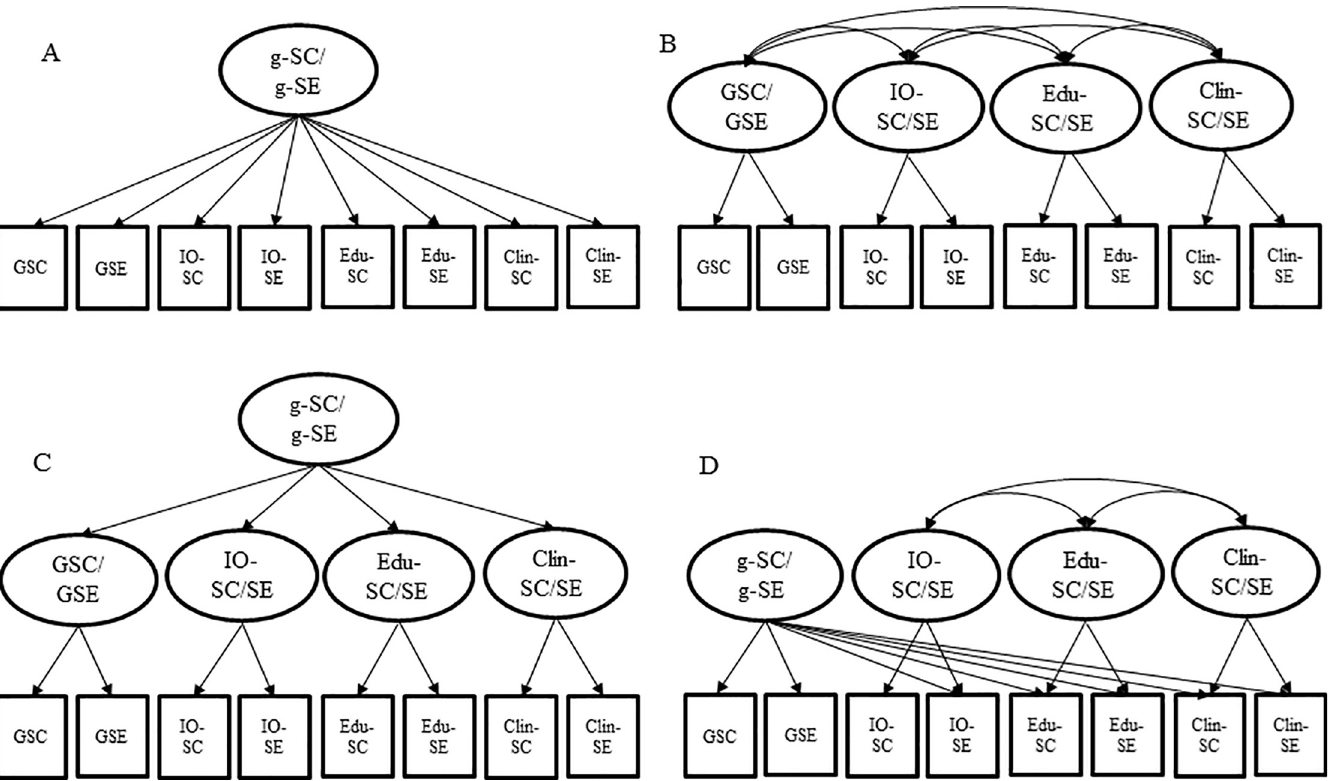
Fig 1. A-D. Four separate structural structural models of ability self-concept and self-efficacy in higher education. SC = Ability self-concept; SE = Self-efficacy; IO = Industrial and Organizational psychology; Edu = Educational psychology; Clin = Clinical psychology; GSC = General self-concept; GSE = General self-efficacy; g = General